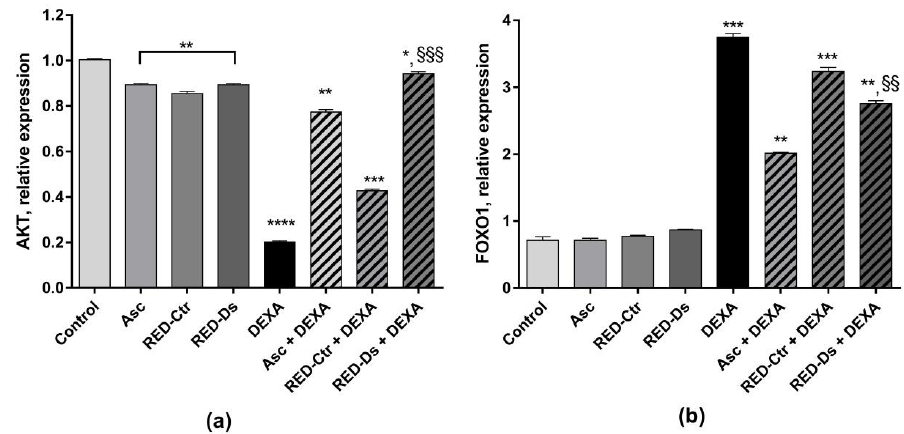
Figure 8. Protein kinase B (AKT) ( a ) and Forkhead BoxO1 (FOXO1) ( b ) mRNA expression in differentiated myotubes. Differentiated myotubes were treated with 50 µ M of DEXA or with 5 µ g GAE/mL (TPC) of ascorbic acid (Asc), Rosso di Pitigliano (RED) extracts of plants grown in normal (RED-Ctr) or in drought stress conditions (RED-Ds), for 48 h. Data show markers relative expression to the untreated cells (control). * p < 0.05, ** p < 0.005, *** p < 0.001 and **** p < 0.0001 vs. control; §§ p < 0.005 and §§§ p < 0.001 vs. DEXA using one-way ANOVA.